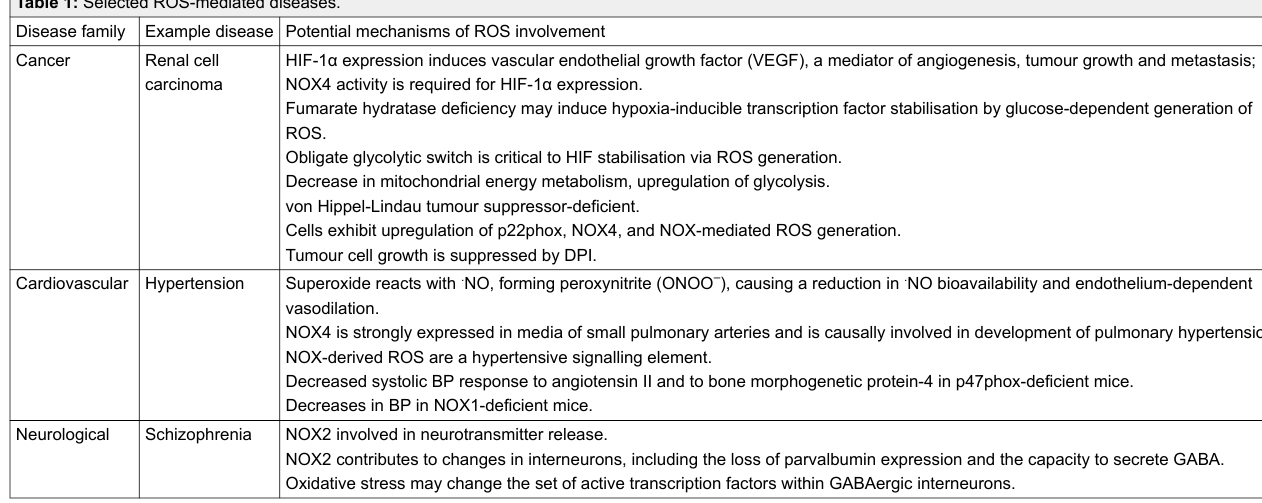
Table 1: Selected ROS-mediated diseases. Disease family Example disease Potential mechanisms of ROS involvement Cancer Renal cell